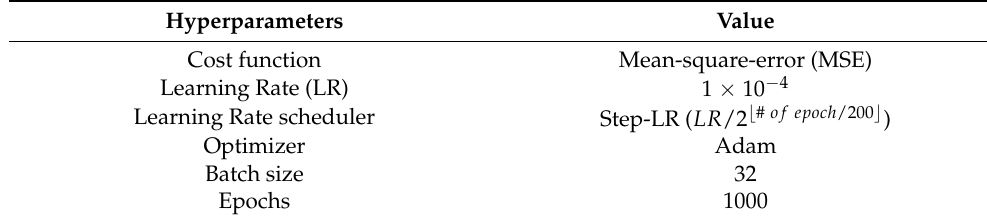
Table 4. Hyperparameters for the